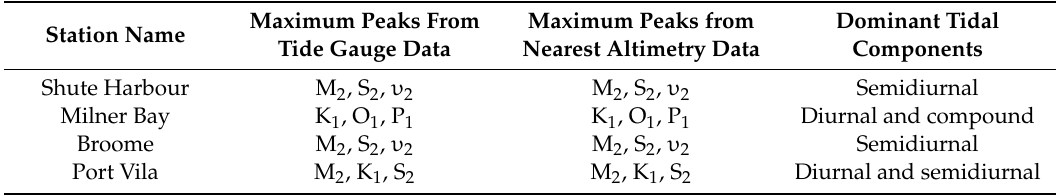
Table 2. Maximum spectral peaks found at three tide gauge stations and their corresponding altimetry data. Maximum Peaks From Station Name Tide Gauge